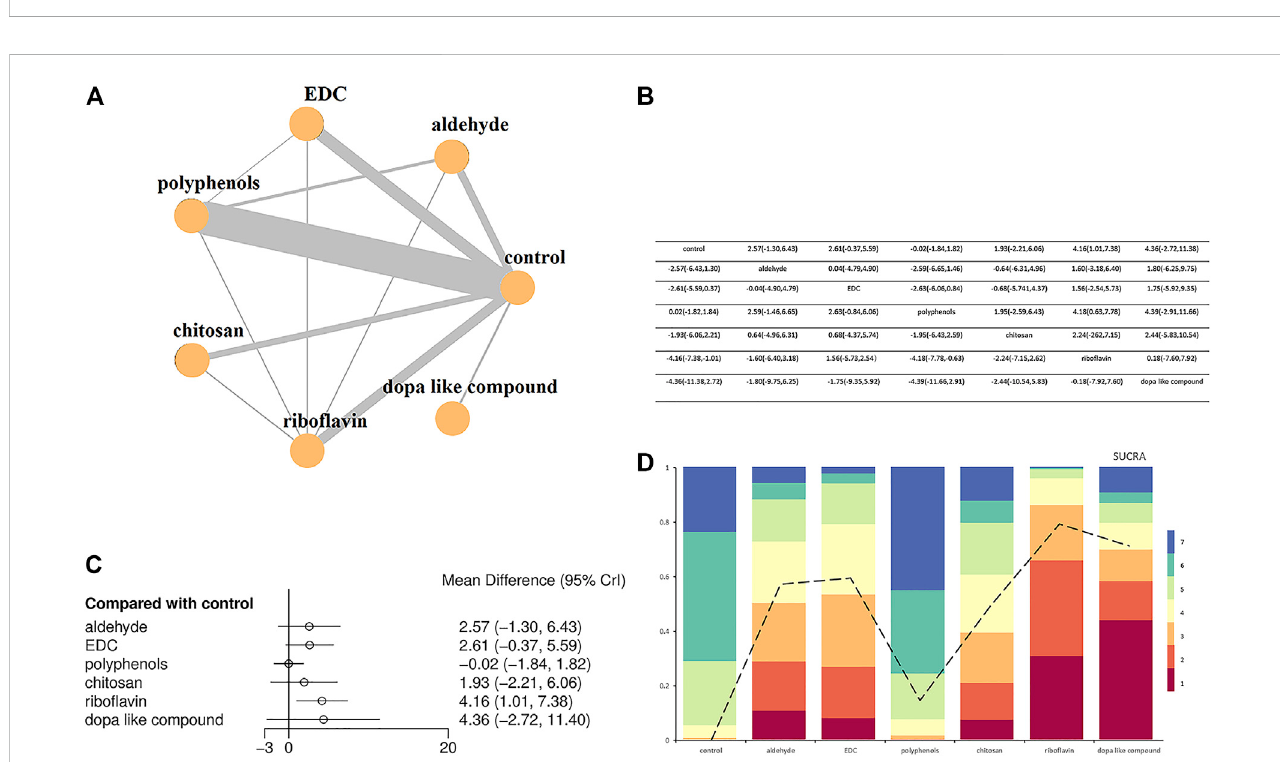
FIGURE 4 Effect of the application category of the adhesive system.